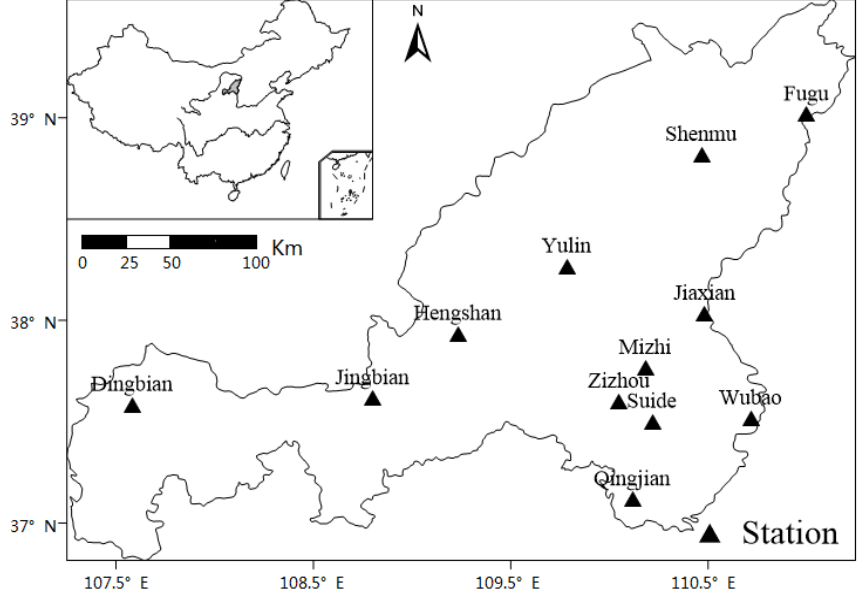
Figure 1. Spatial distribution of meteorological stations in Yulin City of the northern Shaanxi.